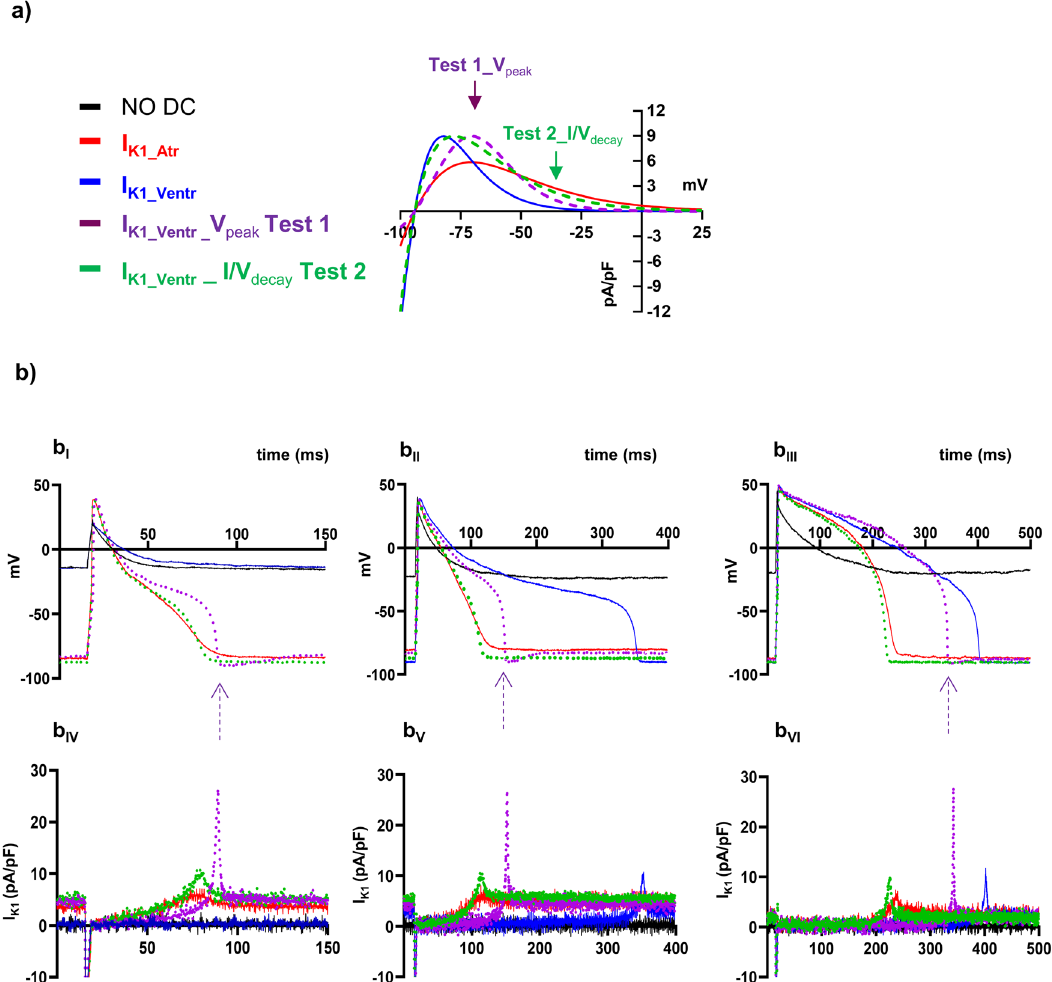
Fig. 3 I K1_Atr vs I K1_Ventr formulation effect on action potential (AP) pro fi le. a I K1_Atr and I K1_Ventr computational model I/V relationships; Test-1 and Test-2 representing V peak and I/V decay changes in I K1_Ventr toward those of I K1_Atr (violet and green dotted lines, respectively). b AP pro fi les (b I-III ) recorded in three hiPSC-CM following the alternative injection of I K1_Ventr (blue), I K1_Atr (red), Test 1_V peak (violet) and Test 2_V decay (green) computational models (b IV-VI ). I-clamp recordings without I K1 injection are represented as black traces in all panels. ( n = 6 – 8 cells, p < 0.05 see Supplementary Tables